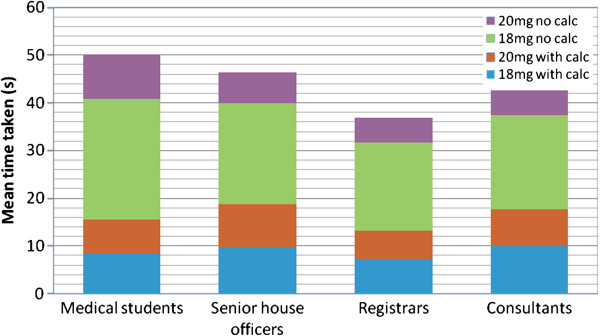
Mean time taken to perform the calculation and category of doctor or medical student.